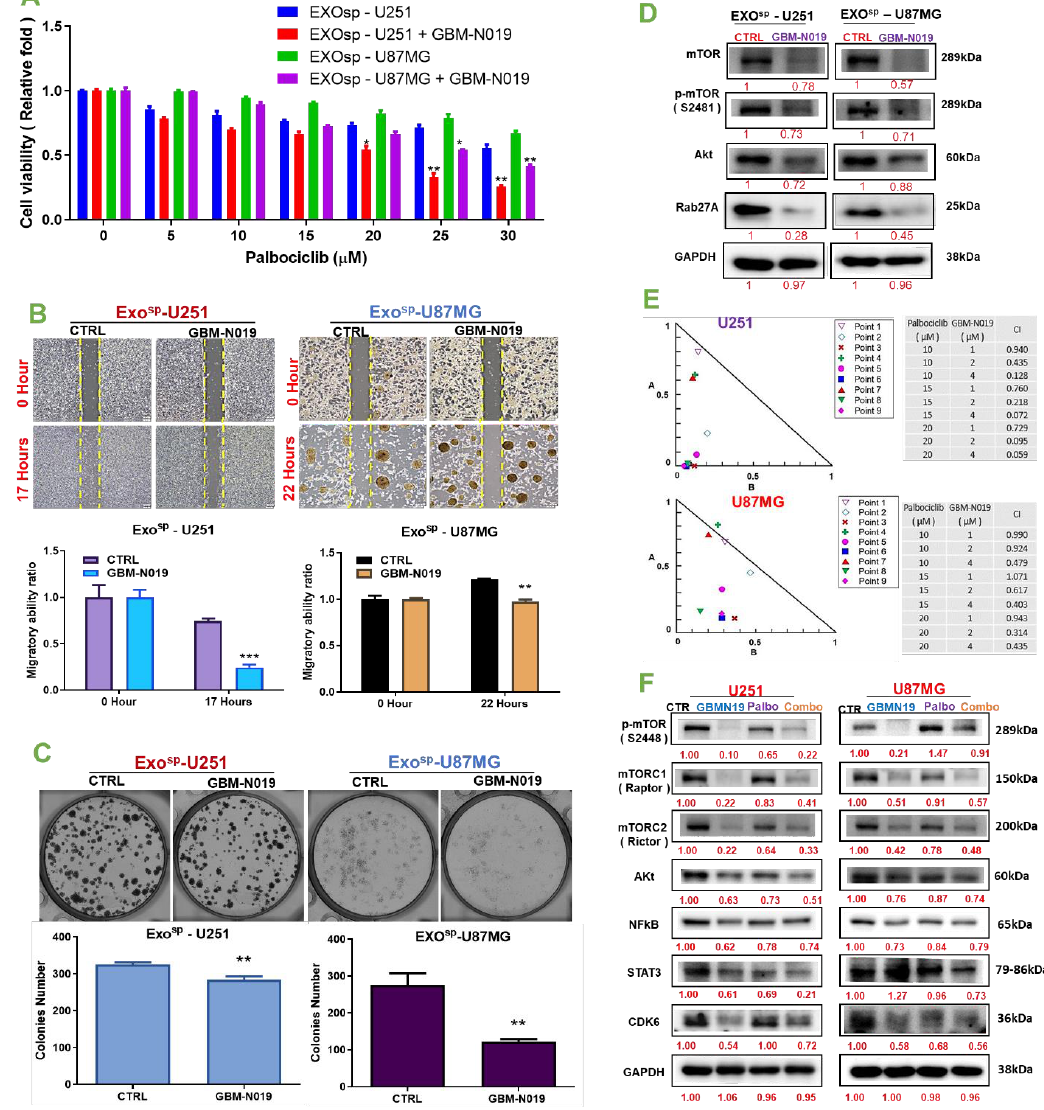
Figure 7. GBM-N019 synergized with palbociclib and re-sensitized the Exo sp -transformed GBM cells to palbociclib treatment. ( A ) Bar graph of cell viability showing that GBM-N019 pretreatment increased the sensitivity of Exo sp -transformed U251 and U87MG cells to palbociclib treatment. GBM-N019 treatment significantly reduced the ( B ) migratory and ( C ) colony forming ability, and ( D ) expression levels of mTOR, p-mTOR, Akt, and RAB27A in Exo sp -transformed U251 and U87MG cells. ( E ) Isobologram analysis showing that the synergistic effects of GBM-N019 and palbociclib was achieved in different concentration combinations in both U251 and U87MG cells. ( F ) Western blot showing that the expression levels of p-mTOR, mTORC1,